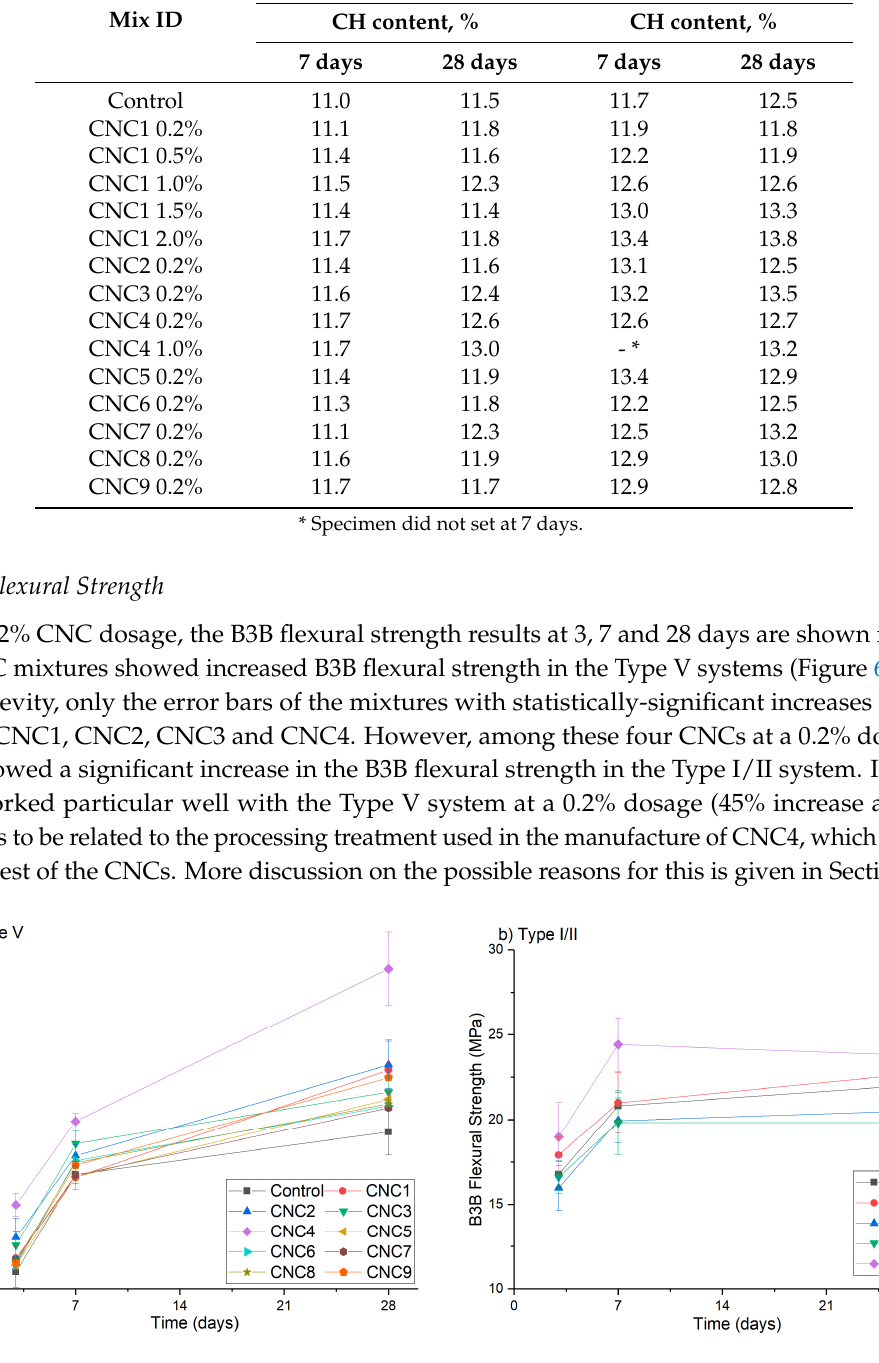
Table 4. Summary of TGA results. CH, calcium hydroxide.